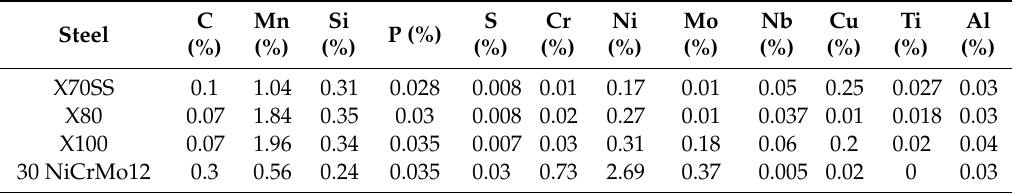
Table 1. Chemical composition of the tested steels (% by